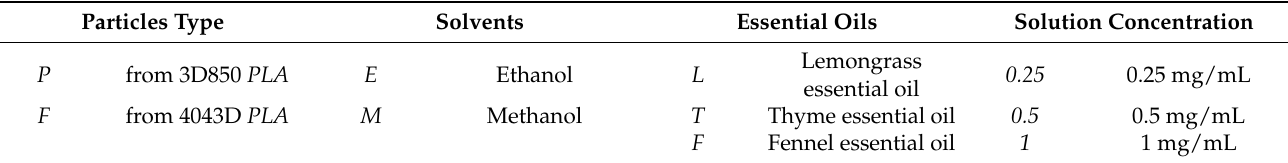
Table 1. Notation for the samples.